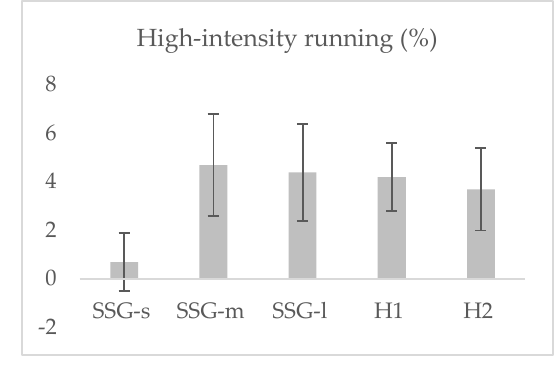
Low-intensity running (%)